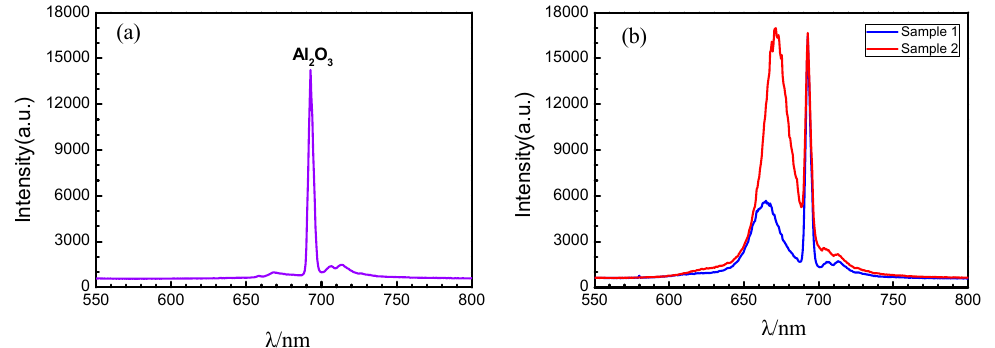
Figure 8. Photoluminescence spectra. ( a ) Clean sapphire substrate and ( b ) single-layer triangular MoS 2 samples deposited on the substrate. Sample 1: the temperature in the high temperature zone is 1073 K; Sample 2: the temperature in the high temperature zone is 1098 K.